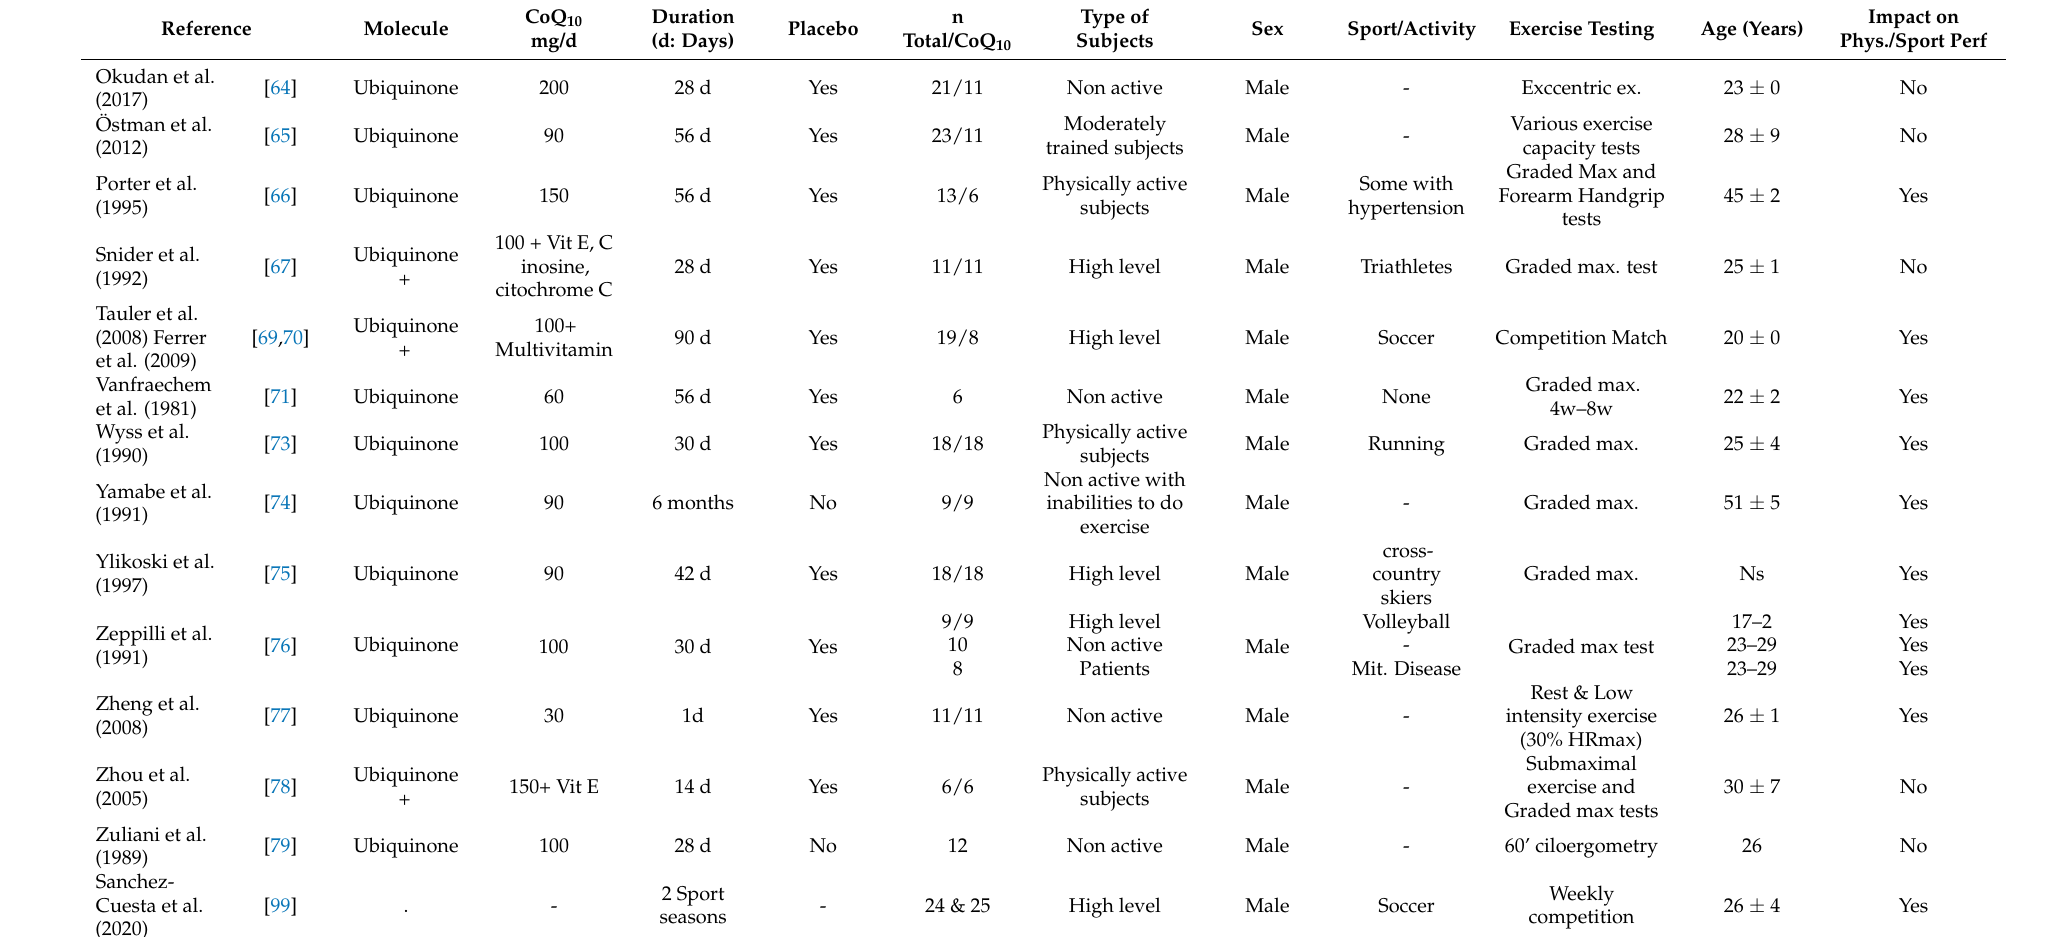
Table 8. Studies without the inclusion